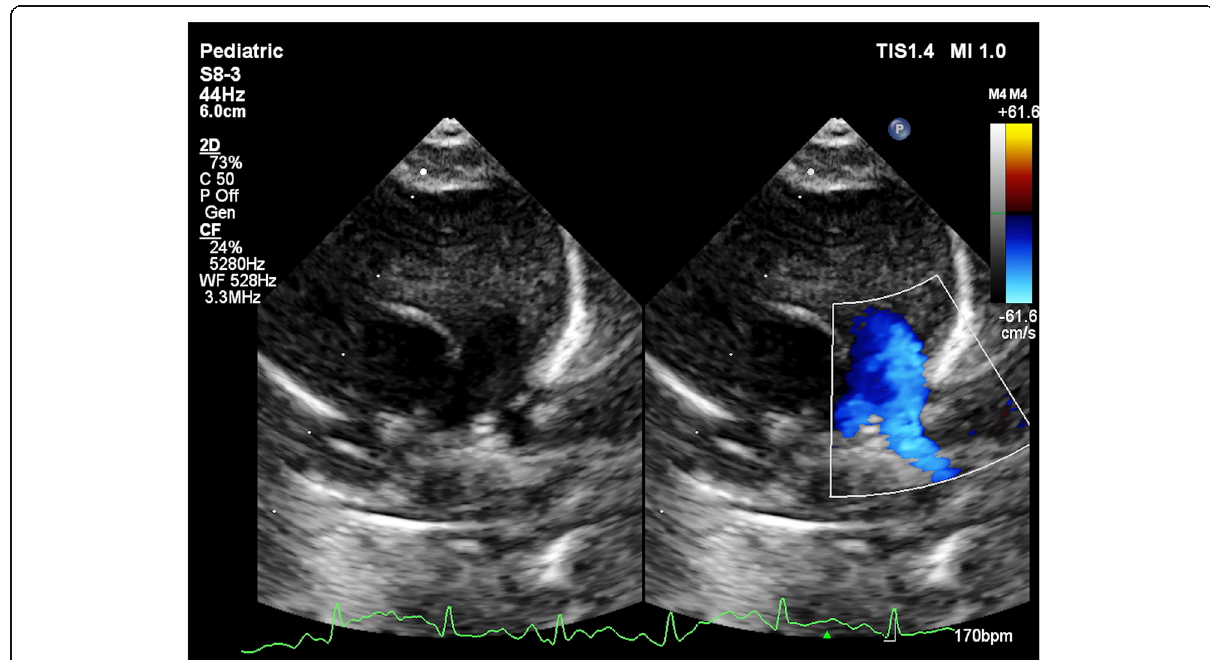
Fig. 3 Repeat echocardiogram after 6 weeks of LMWH. Colour Doppler in parasternal short axis view showing partial resolution of thrombus in LPA